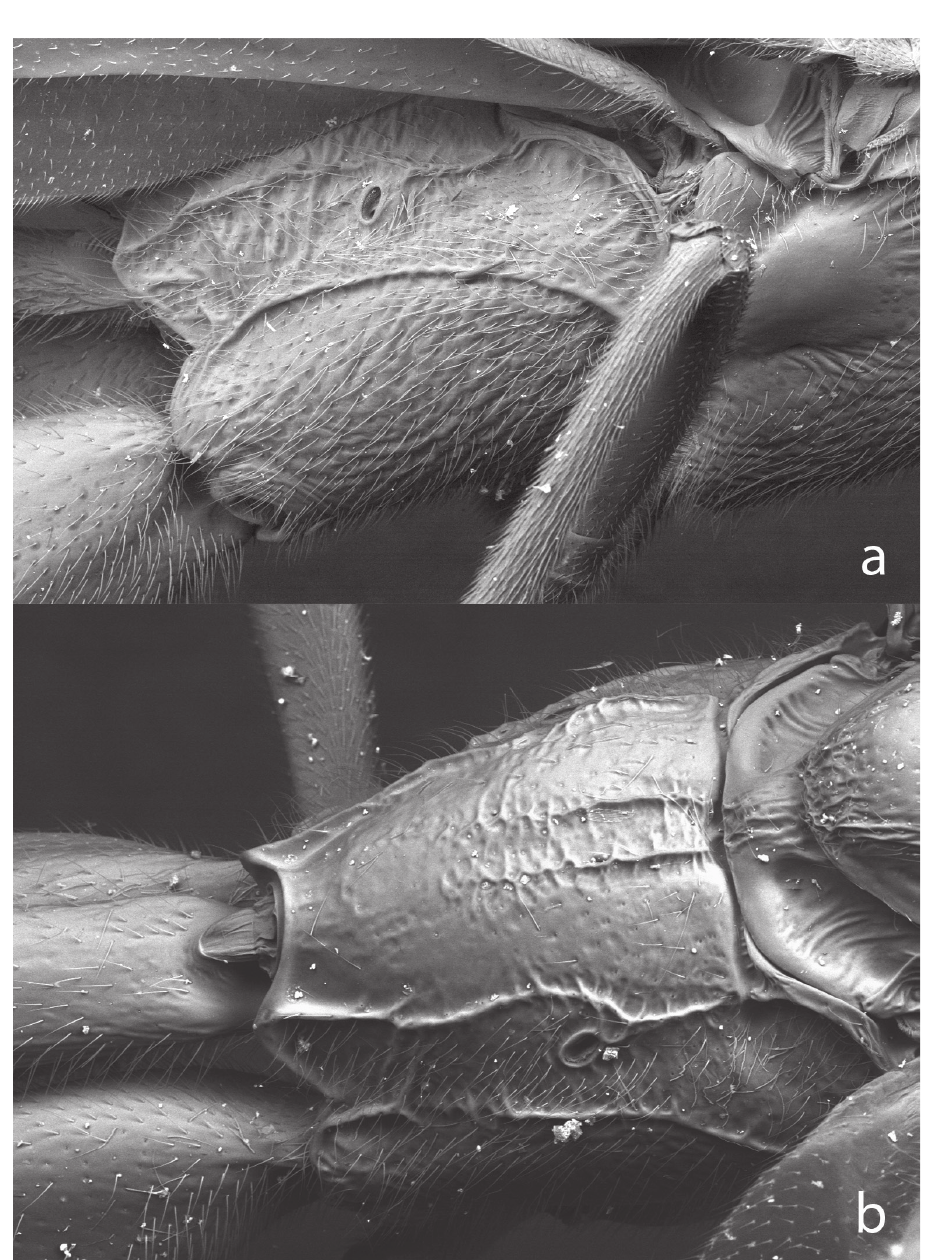
Figure 5. Propodeum of Bicurta sinica a and Collyria coxator b . Figs 5–9 , SEMs of uncoated tively large, elongate punctures. Lower portion of mesopleuron slightly scabrous, with dense punctures; dorsoanterior portion, in front of subalar prominence, with short longitudinal wrinkles; median portion (anterior to speculum) and ventroposterior por-